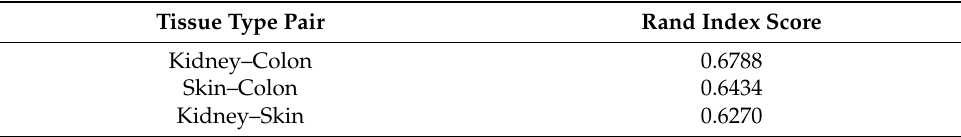
Table 6. Rand index results for all possible tissue type